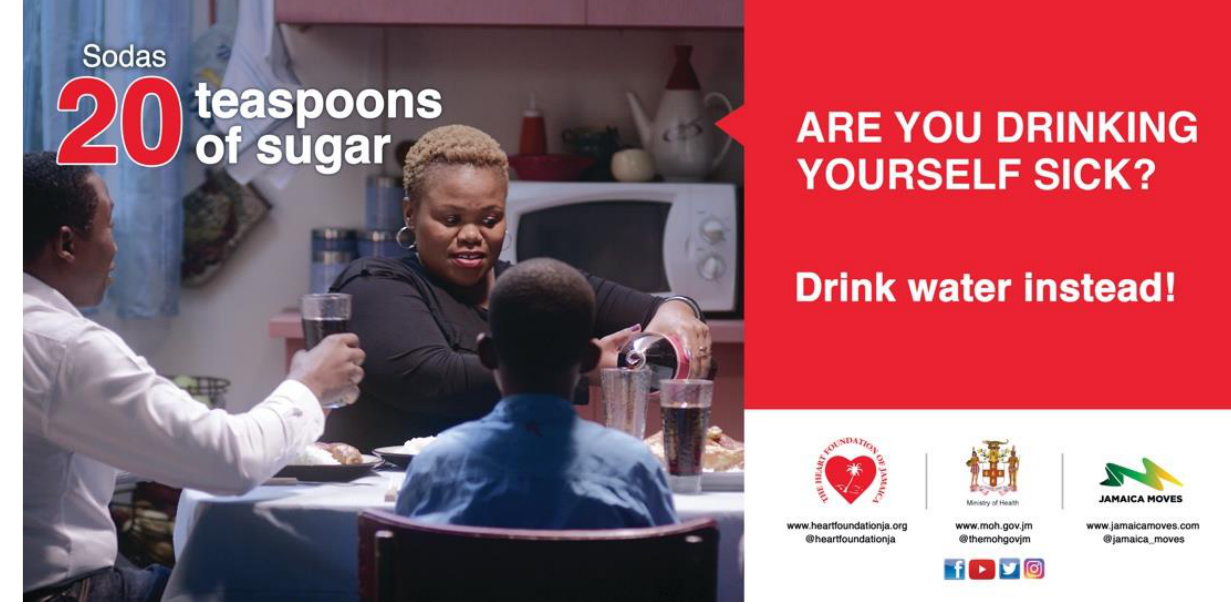
Figure 1. Superboard ad, Jamaica, 2017 —“Are You Drinking Yourself Sick?” (Phase I).